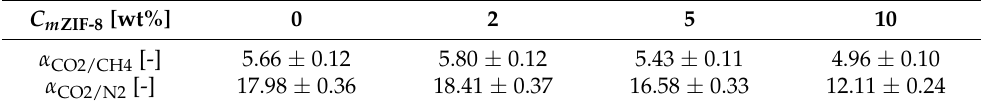
Table 5. Coefficients of ideal selectivity α i/j for membranes of different ZIF-8 concentrations.